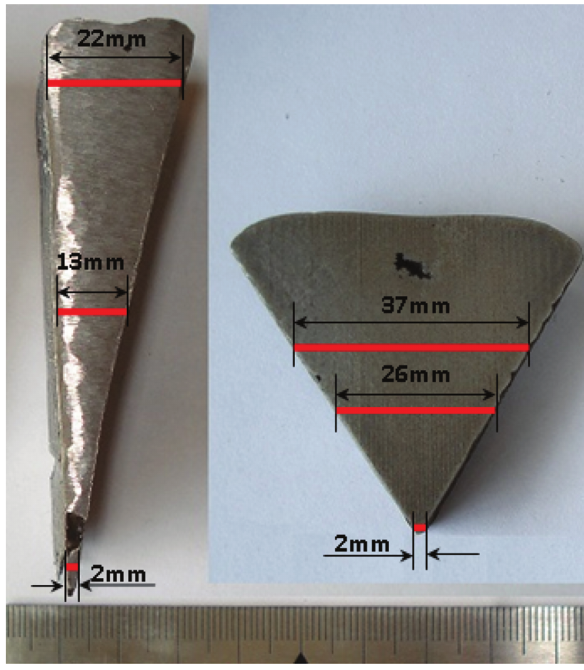
Figure 3: Cross sections of the cast sample 1 (left) and sample 2